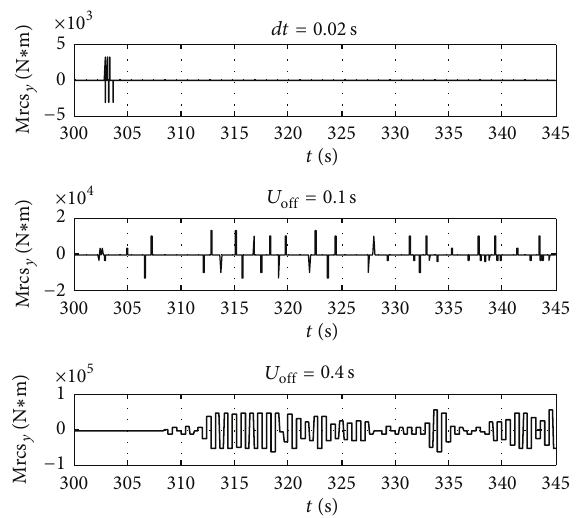
Figure 36: Simulation result of RCS yaw moment.